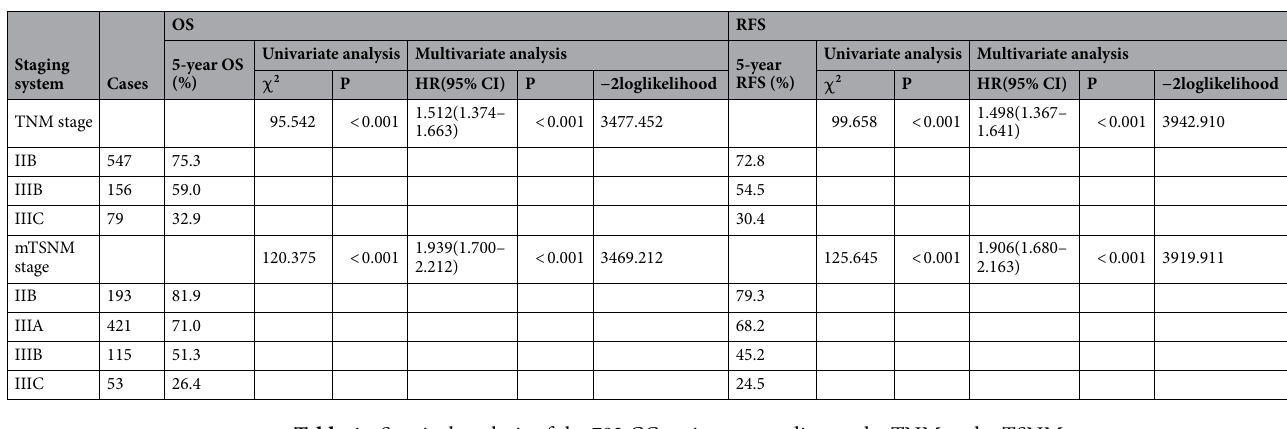
Table 4. Survival analysis of the 782 CC patients according to the TNM and mTSNM stages.